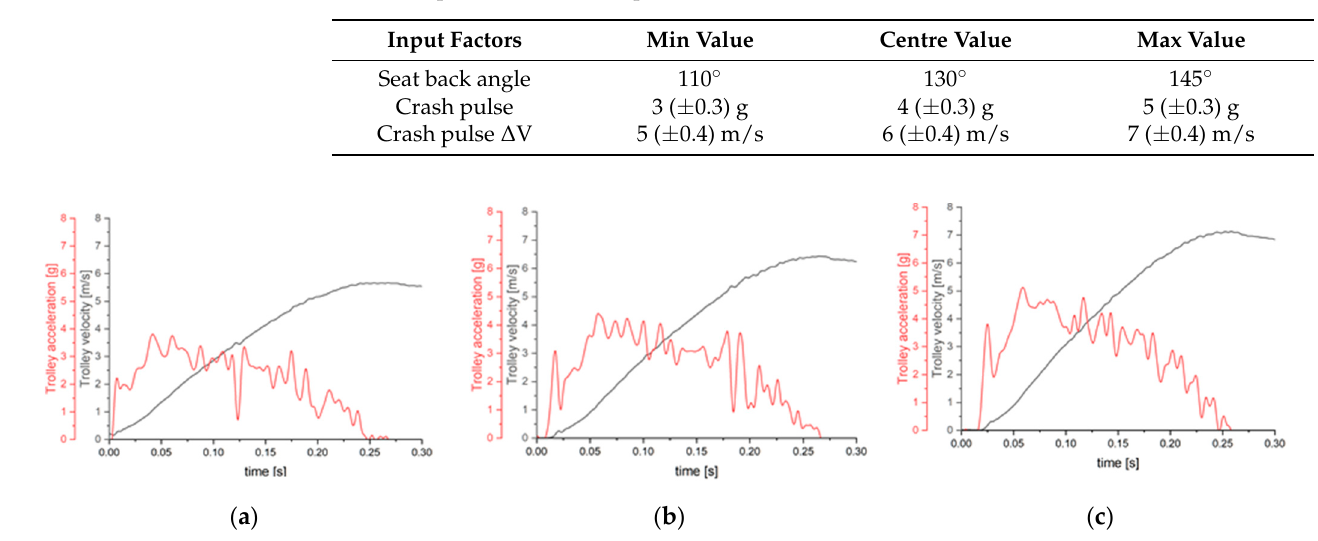
Table 1. Input factors of the experiment.